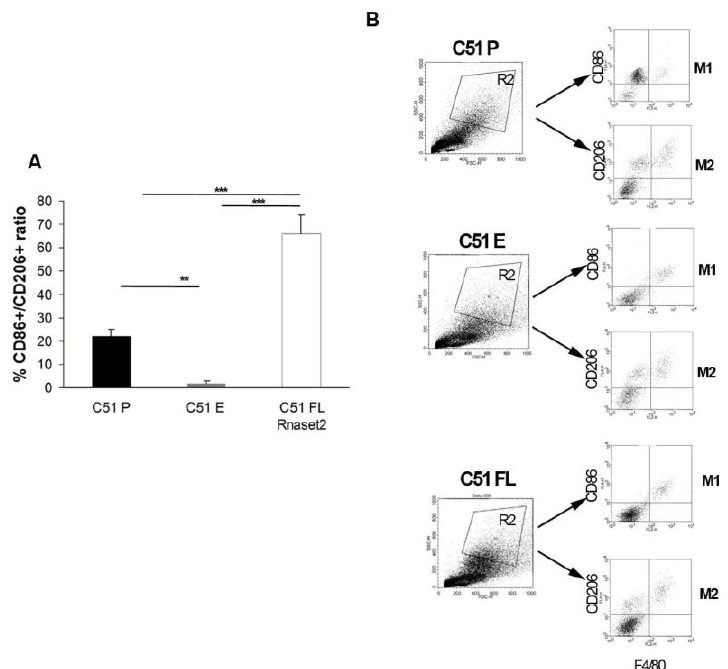
Figure 6. Cytometric flow assessment after in vitro tumor digestion has been performed to study percentage of intra-tumor CD45 + CD86 + M1 and CD206 + M2 macrophage ratio in BALB / c mice ( N = three animals in group) injected with C51 P, C51 E and C51 FL Rnaset2 cell lines (panel A ); gating strategy for flow cytometry (FACS) analysis of surface markers in M1 (F4 / 80 + CD86 + ) and M2 (F4 / 80 + CD206 + ) macrophages (panel B ). An ANOVA statistical analysis was performed assuming p < 0.05 as a threshold value. * p < 0.05; ** p < 0.01; *** p < 0.001.